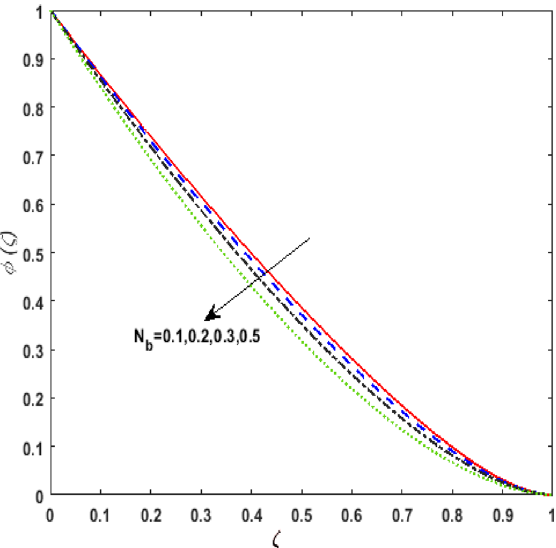
Figure 14. Effect of Brownian diffusion parameter N b on concentration φ(ζ)